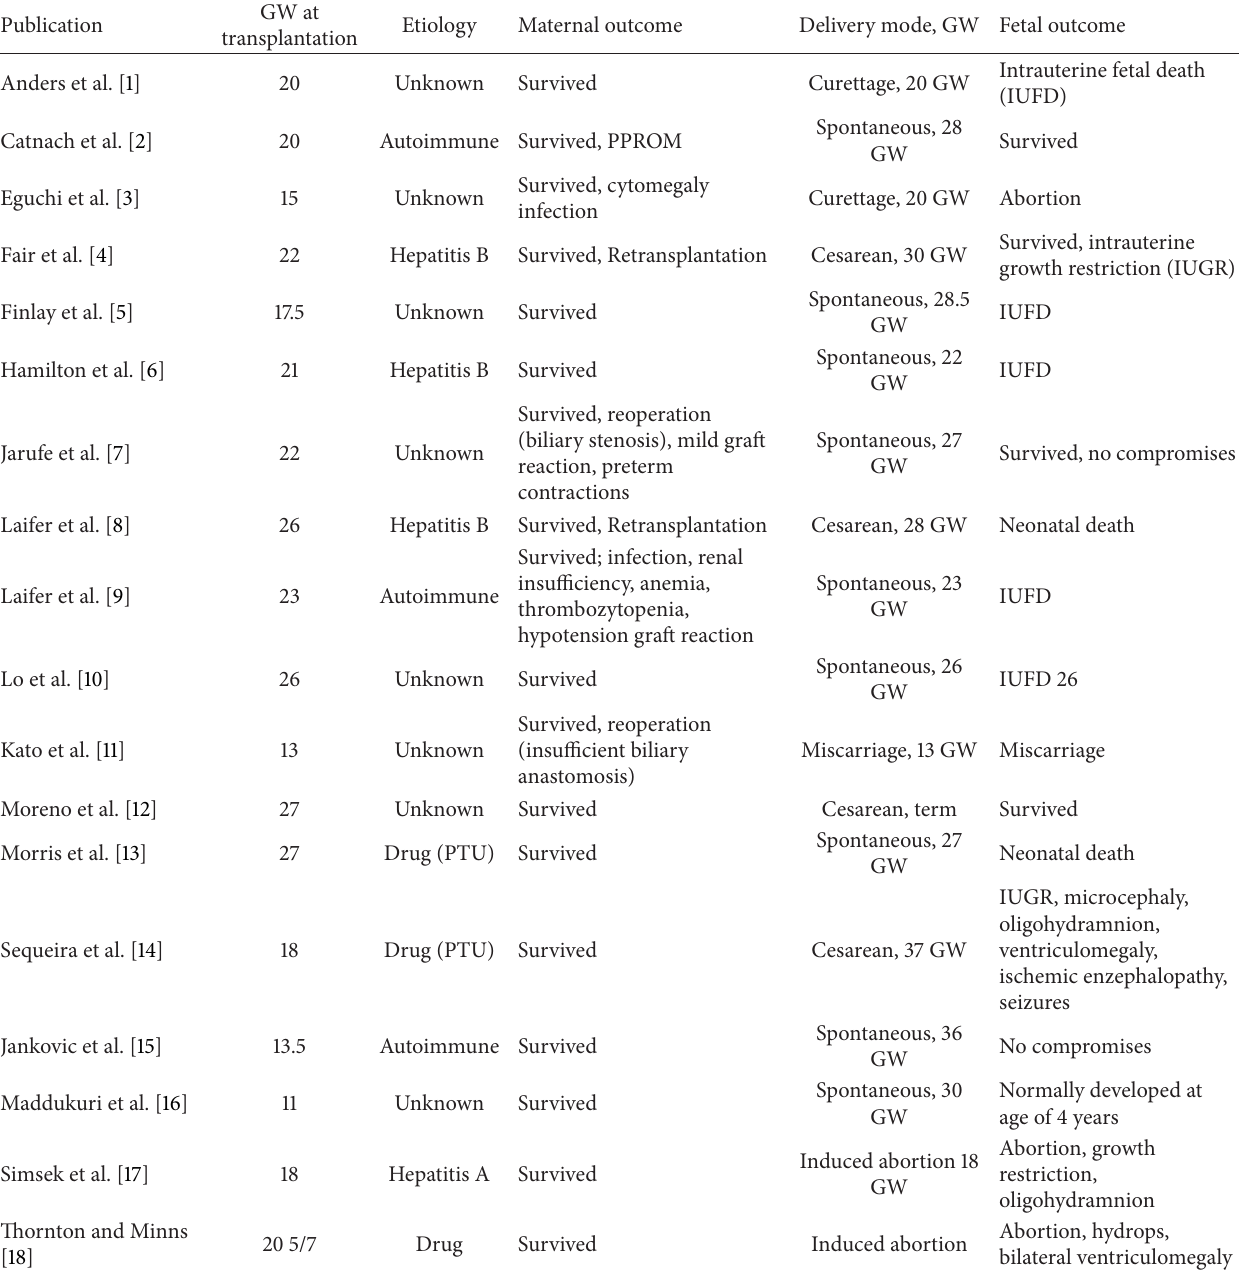
Table 3: Eighteen other cases of liver transplantation during pregnancy in the